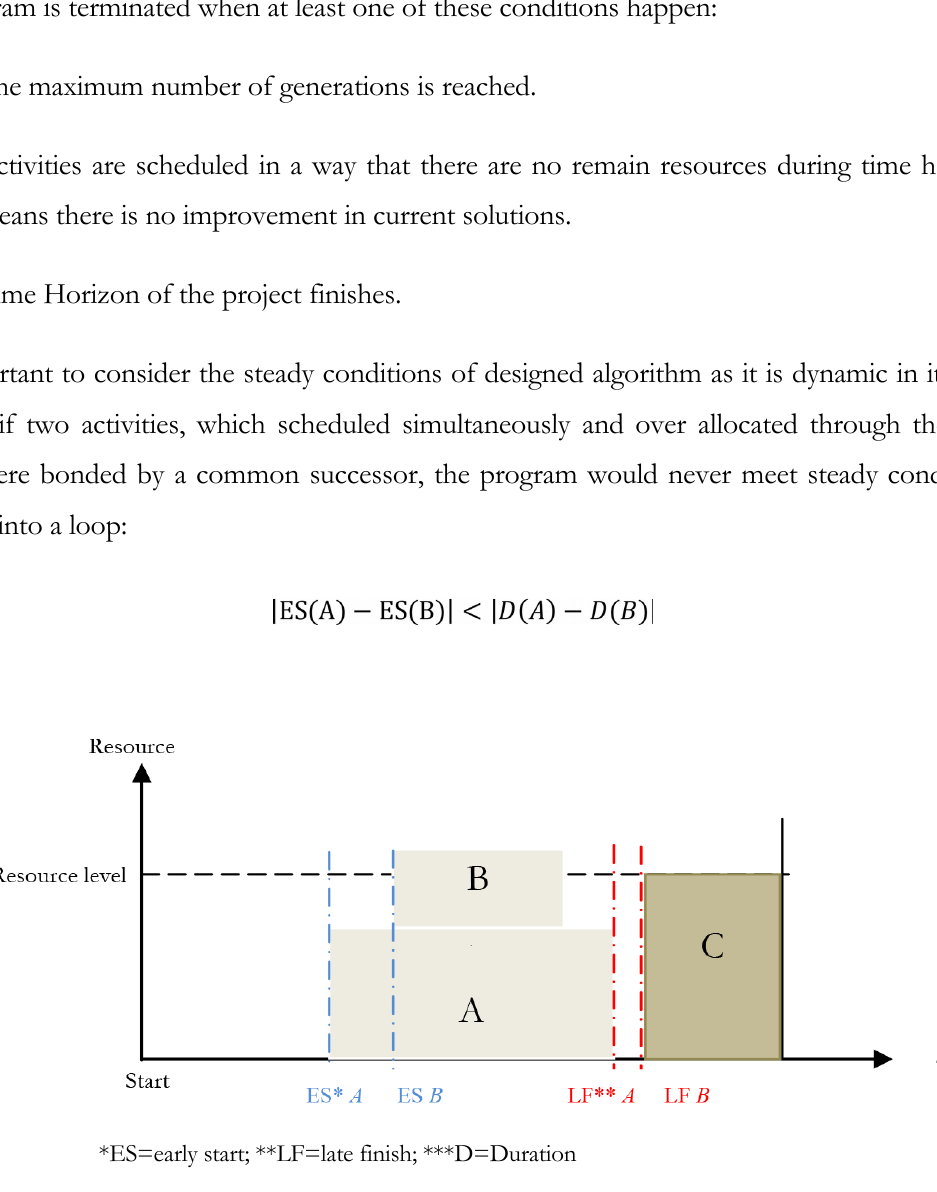
Figure 6. A graphical sample of unsteady condition of